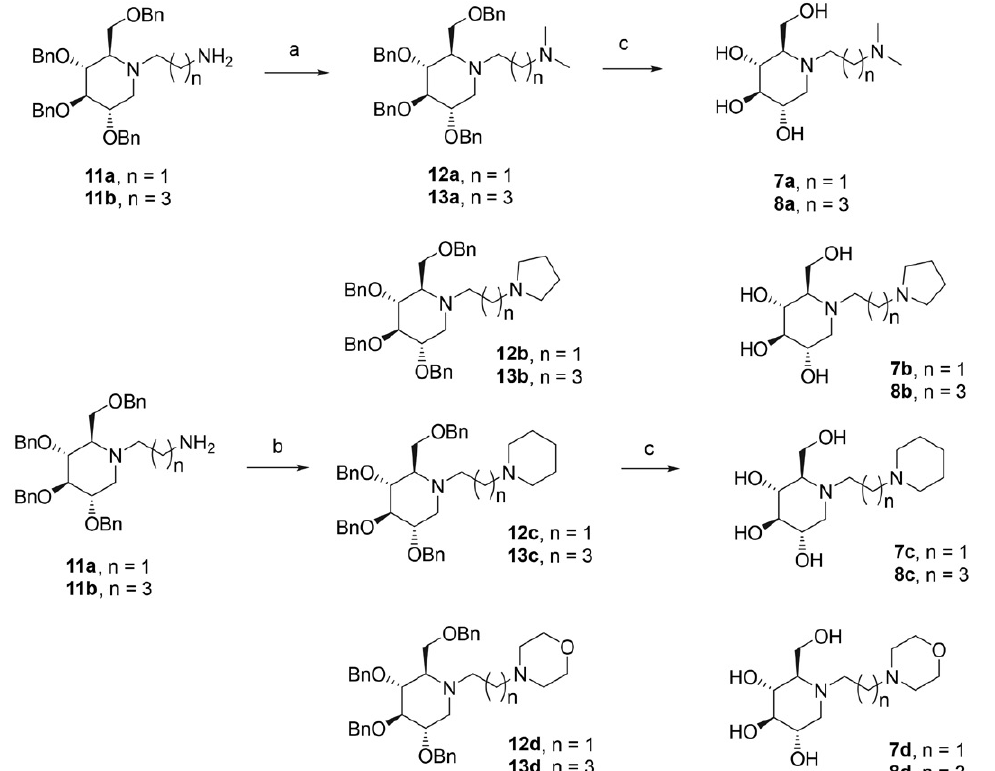
Scheme 2. Synthesis of N -alkylated derivatives of 1-deoxynojirimycin. Reagents and conditions: (a) HCHO, HCOOH, 105 °C, 3 h, 83% ( 12a ), 90% ( 13a ); (b) alkyl dibromide, K 2 CO 3 , CH 3 CN, 80 °C, 12 h, 84% ( 12b ), 81% ( 13b ), 80% ( 12c ), 82% ( 13c ), 85% ( 12d ), 87% ( 13d ); (c) H 2 , 10% Pd/C,